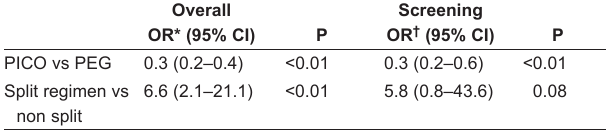
TAble 2 Head-to-head comparison of different bowel preparations in terms of quality of preparation, adjusted for potential confounders in turn